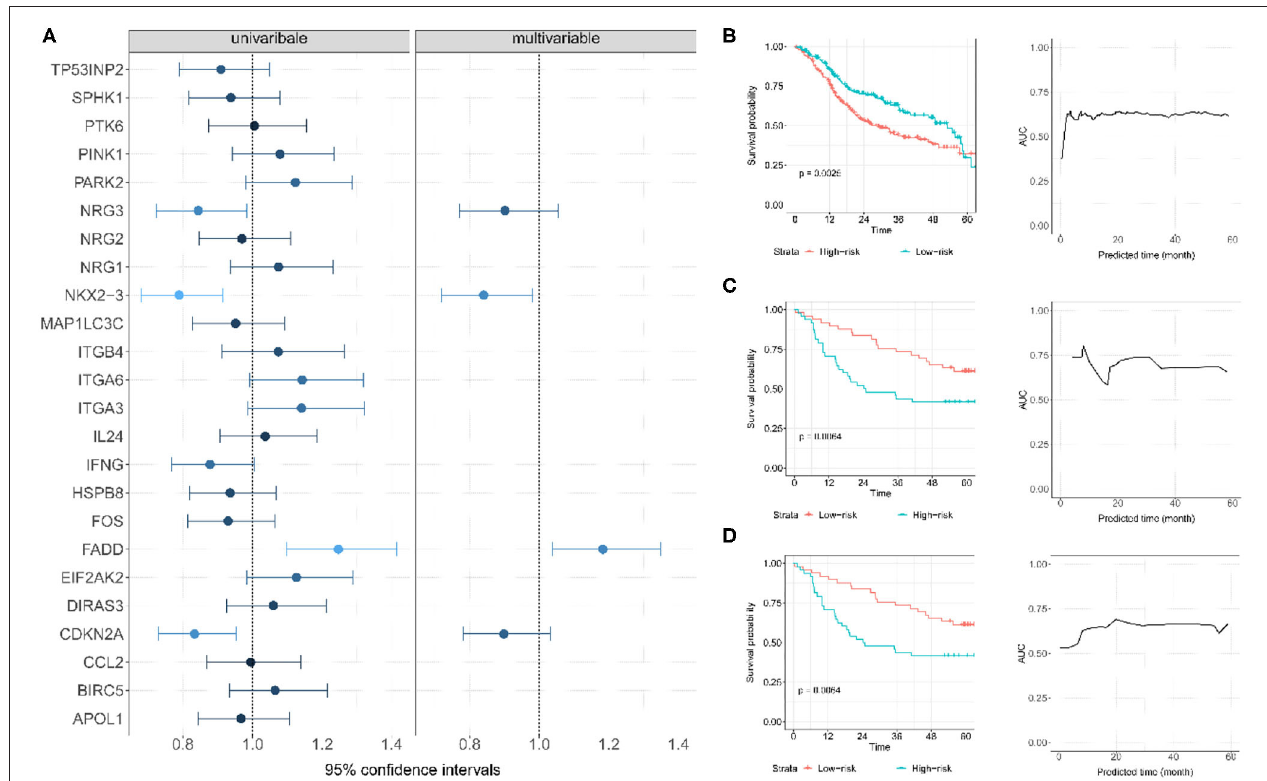
FIGURE 4 | (A) Establishment of autophagy-related gene signature and predictive value analysis for OS of OSCC patients based on TCGA dataset. (B) The survival probability and time-dependent ROC curve for TCGA; each patient was divided into low- and high-risk score groups according to the median of the risk score; (C) The survival probability and time-dependent ROC curve for GSE85446. (D) The survival probability and time-dependent ROC curve for